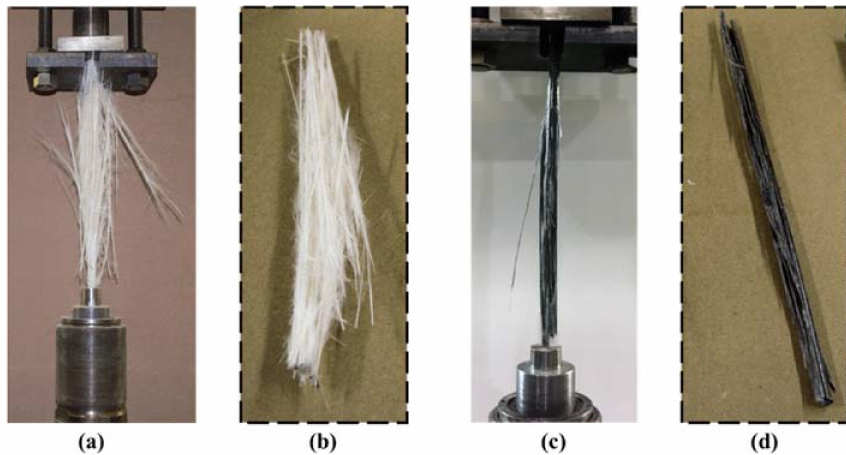
Figure 10. Longitudinal tension failure modes of pultruded GFRP bars with ( a ) complete setup of neat pultruded GFRP bars, ( b ) failed specimen of neat pultruded GFRP bars, ( c ) complete setup of pultruded bars with 0.5 wt.% COOH-MWCNTs and ( d ) failed specimen of pultruded bars